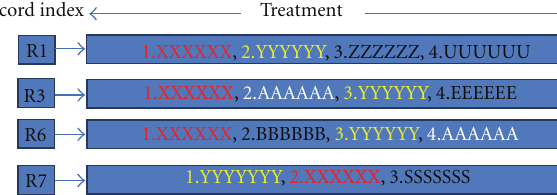
Figure 7: Extract most frequently used treatment from similar history